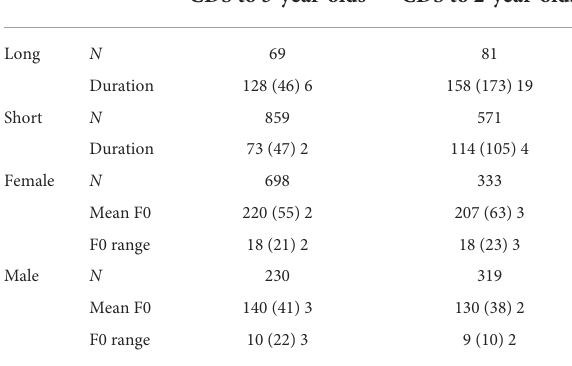
TABLE 5 Duration (ms), mean F0, and F0 range (Hz) for vowels in Nungon CDS by 10 speakers: mean (standard deviation) standard error. CDS to 3-year-olds CDS to